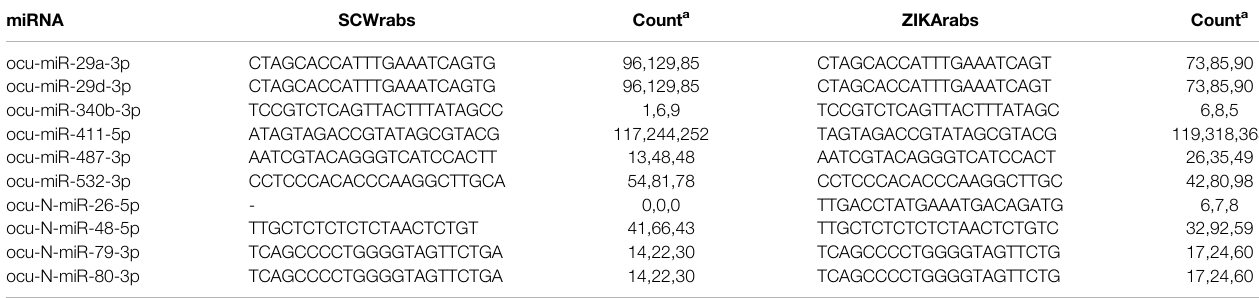
TABLE 4 | miRNA isoforms identi fi ed in the muscle tissues of SCWrabs and ZIKArabs. miRNA